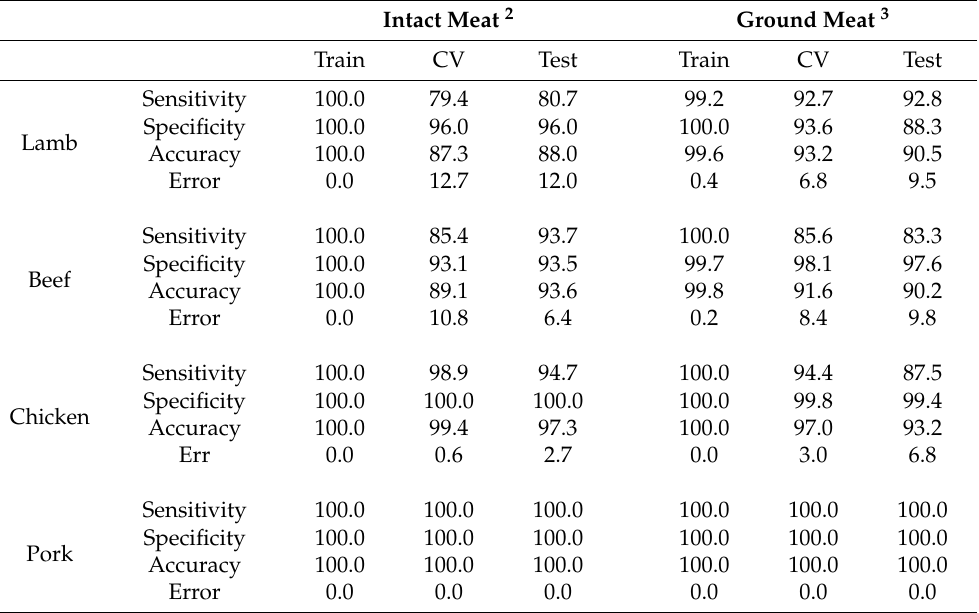
Table 5. Classification performance (in %) of SVM (kernel function: quadratic) model 1 for classifica- tion of lamb, beef, chicken and pork using six individual spectra of each sample for the Vis-NIR sensor. Intact Meat 2